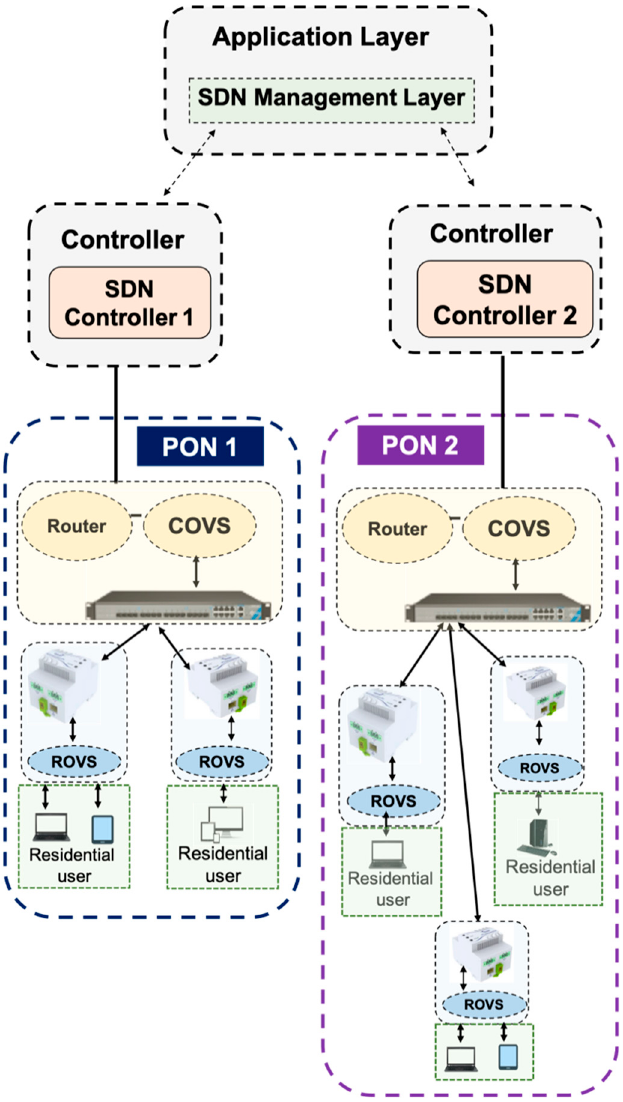
Figure 2. Block diagram of our OpenFlow approach over GPONs to apply external service configuration policies.